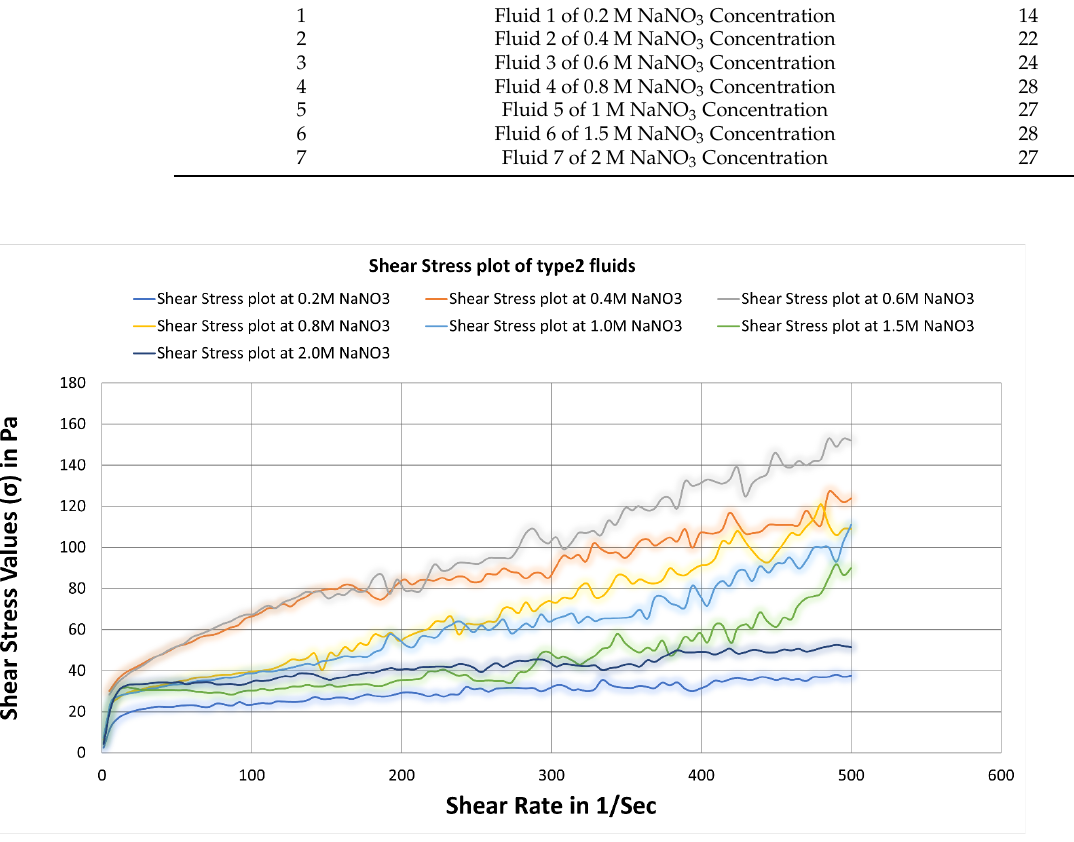
Figure 13. Shear stress vs shear rate curves for surfactant-based viscoelastic fluids of type2 with varying NaNO 3 concentrations at 25 °C. The yield stress characteristic of complex fluids or non-Newtonian fluids is a prop- erty associated with the material not flowing unless the applied stress exceeds a specific value. The yield stress is the stress value that must be applied to the sample before it starts to flow. Similarly, like stretching a spring, the sample deforms elastically below the yield stress; above the yield stress, the sample flows like a liquid [38,49]. The Figure 14 shows the shear stress of a complex fluid which appears to have yield stress but shows viscous behavior at much lower shear rates. This is similar case for SBVE fluids showing rubber-like elastic behavior below the yield stress. Figure 14. A Plot of shear stress of material that appears to have yield stress but shows viscous be- havior at much lower shear rates [50].